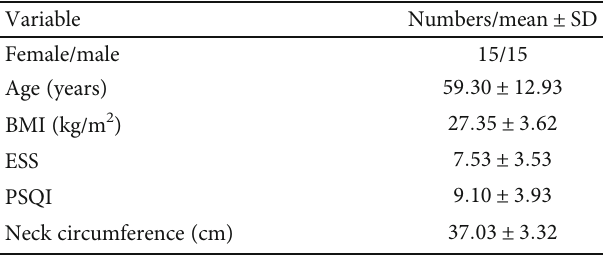
Figure 1: (a) Diagram of the smart antisnore pillow (SAP) device. (b) The working diagram of SAP: the head changes position when the snore sensors detect snoring and the SAP mobile foam shifts horizontally (A: snore sensor; ⟶ : points out A ’ s location). Table 1: Demographic characteristics of 30 patients.